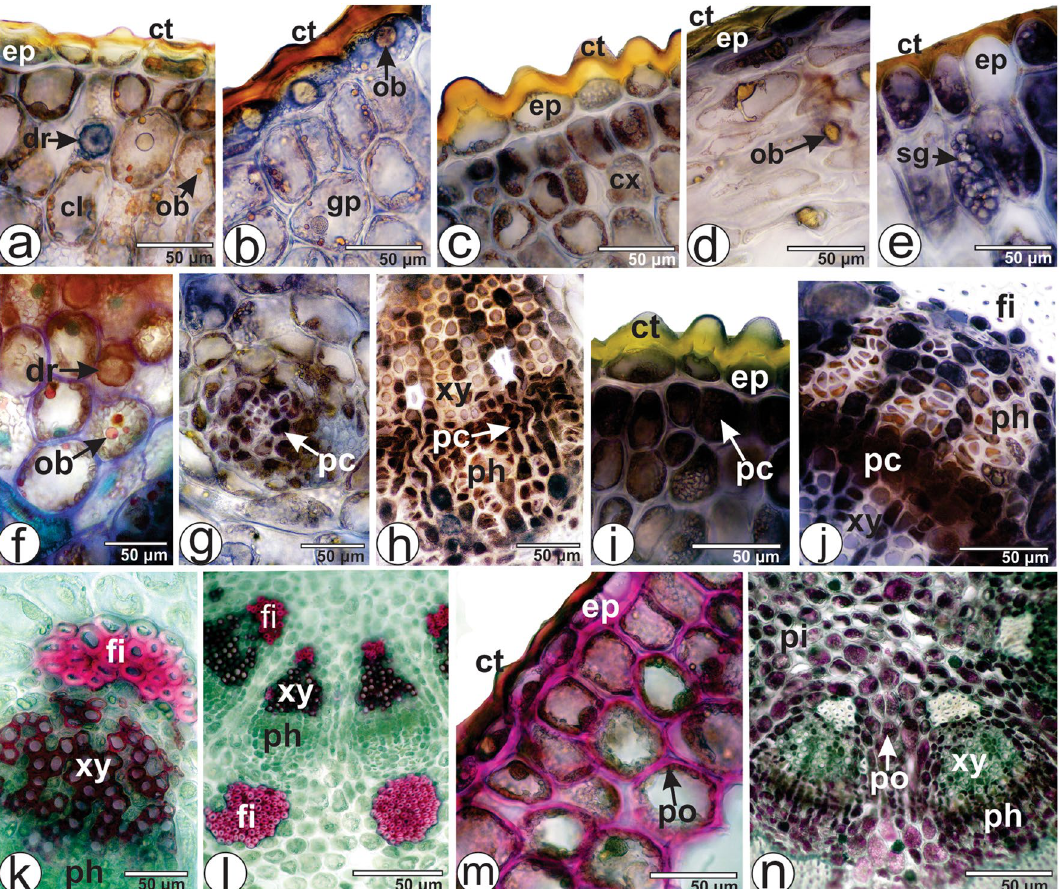
Figure 6. Microchemical tests of Viscum album subsp. album in cross-section. ( a , b , g , h , k , m ) Leaf [( a , g ) Lamina, ( f , m , k ) Midrib, ( b , h ) Petiole]. ( c , i , j , l , n ) Stem. ( d ) Berry. ( e ) Seed. Reagents: ( a – e ) Sudan III. ( f ) Nile blue. ( g , h ) Potassium dichromate. ( i , j ) Ferric chloride. ( k , l ) Phloroglucinol/HCl. ( m , n ) PAS (periodic acid-Schiff reagent). cl chlorenchyma, ct cuticle, cx cortex, dr druses, ep epidermis, fi fibers, gp ground parenchyma, hy hypocotyl, ob oil bodies, pc phenolic compounds, ph phloem, po neutral polysaccharides, sg starch grain, xy